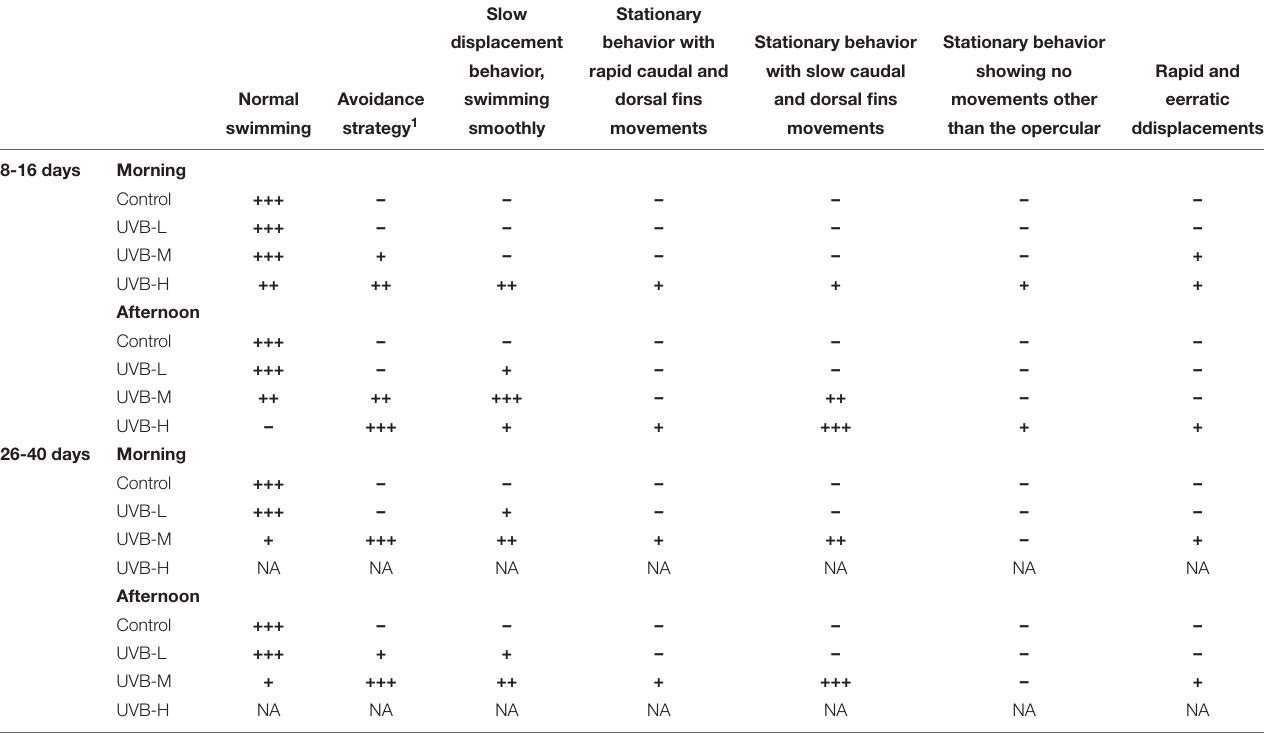
TABLE 3 | Ethogram of the changes in swimming behavior observed in S. aurata during 43 days of exposure to UVB.